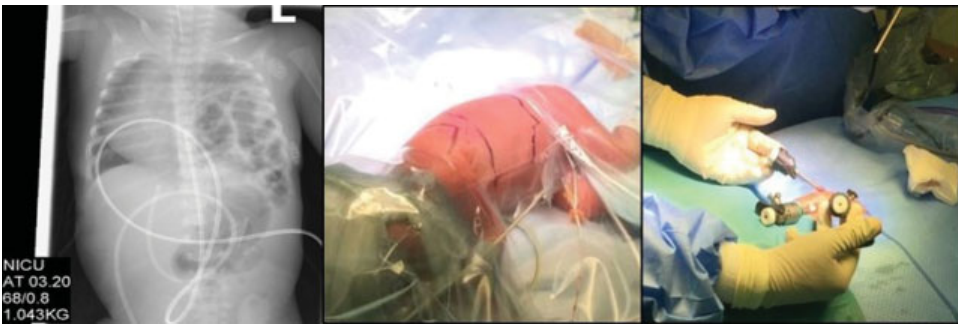
Fig. 1 Postnatal X-ray, left-sided congenital diaphragmatic hernia. Patient position and placement of the ports. NICU, neonatal intensive care